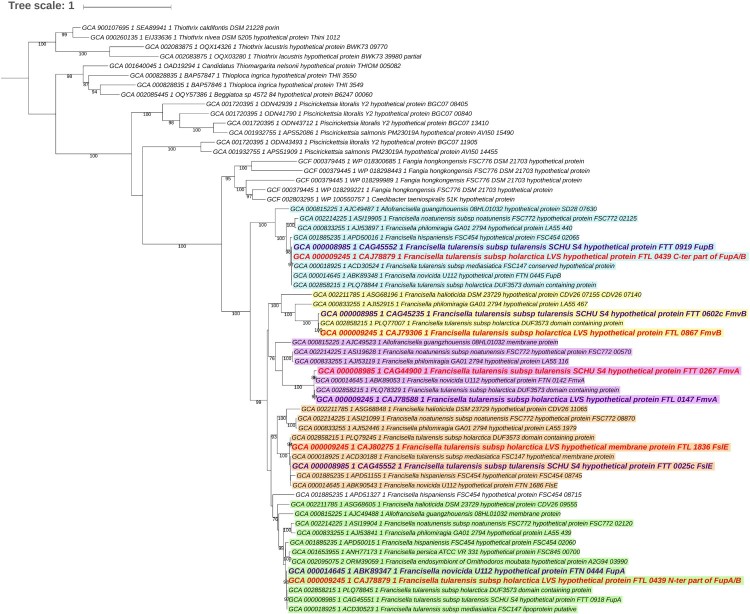
Maximum likelihood tree of DUF3573-containing proteins in Thiotrichales (62 sequences, 303 amino acid positions used). The 62 sequences were selected among the 1,214 homologs identified in the 384 Thiotrichales proteomes available at the NCBI, by keeping sequences from one representative strain per species or subspecies in the case of Francisella. The scale bar represents the average number of substitutions per site. Numbers at nodes correspond to ultrafast approximated bootstrap values. For clarity, values lower than 75% are not shown. The five protein subfamilies corresponding to FupA, FupB, FslE, FmvA, and FmvB are shown in green, blue, orange, pink, and yellow. The five sequences from Francisella tularensis subsp. tularensis SCHU S4 and the four sequences from F. tularensis subsp. holarctica LVS are shown in purple and red, respectively. Noteworthy, in the latter as in other LVS strains, FupA and FupB are fused. Regions corresponding to FupA and FupB in the LVS strain were analyzed separately to infer this tree. As expected, they group within subfamilies corresponding to FupA and FupB, respectively.